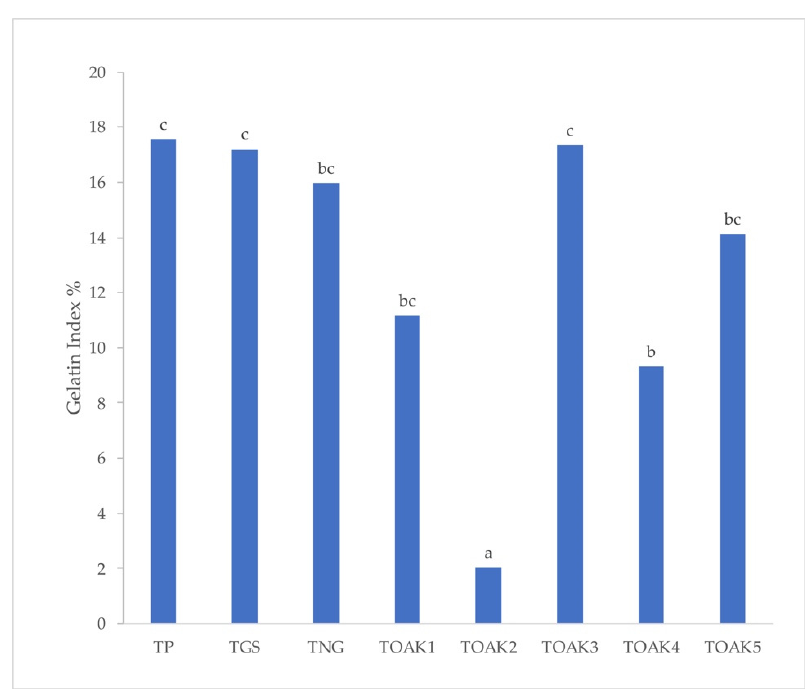
Figure 3. Reaction kinetics of the analyzed tannins dissolved in the model wine solution with gelatin from bovine serum albumin, and Δ NTU (nephelometric turbidity unit). Pomegranate tannin; TGS, grape seed tannin; TNG, Nut gall tannin; TOAK1, TOAK2, TOAK3, TOAK4, TOAK5, Oak tannin 1– 5, respectively.